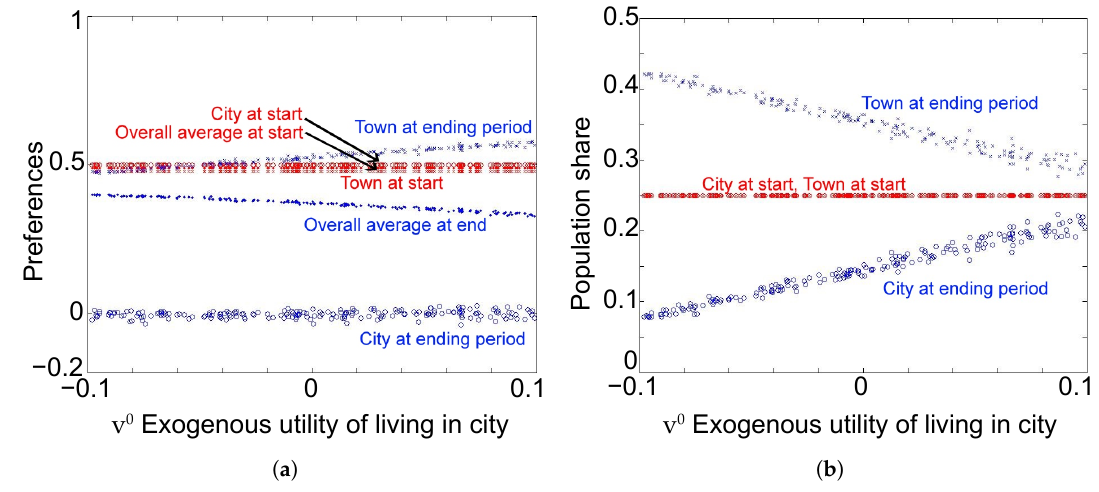
Figure 5. The Monte Carlo simulation with varying exogenous utility of city v 0 . Notation follows that of Figure 3a. ( a ) average preferences of ethnicity ⊕ ; ( b ) population shares of city and town +